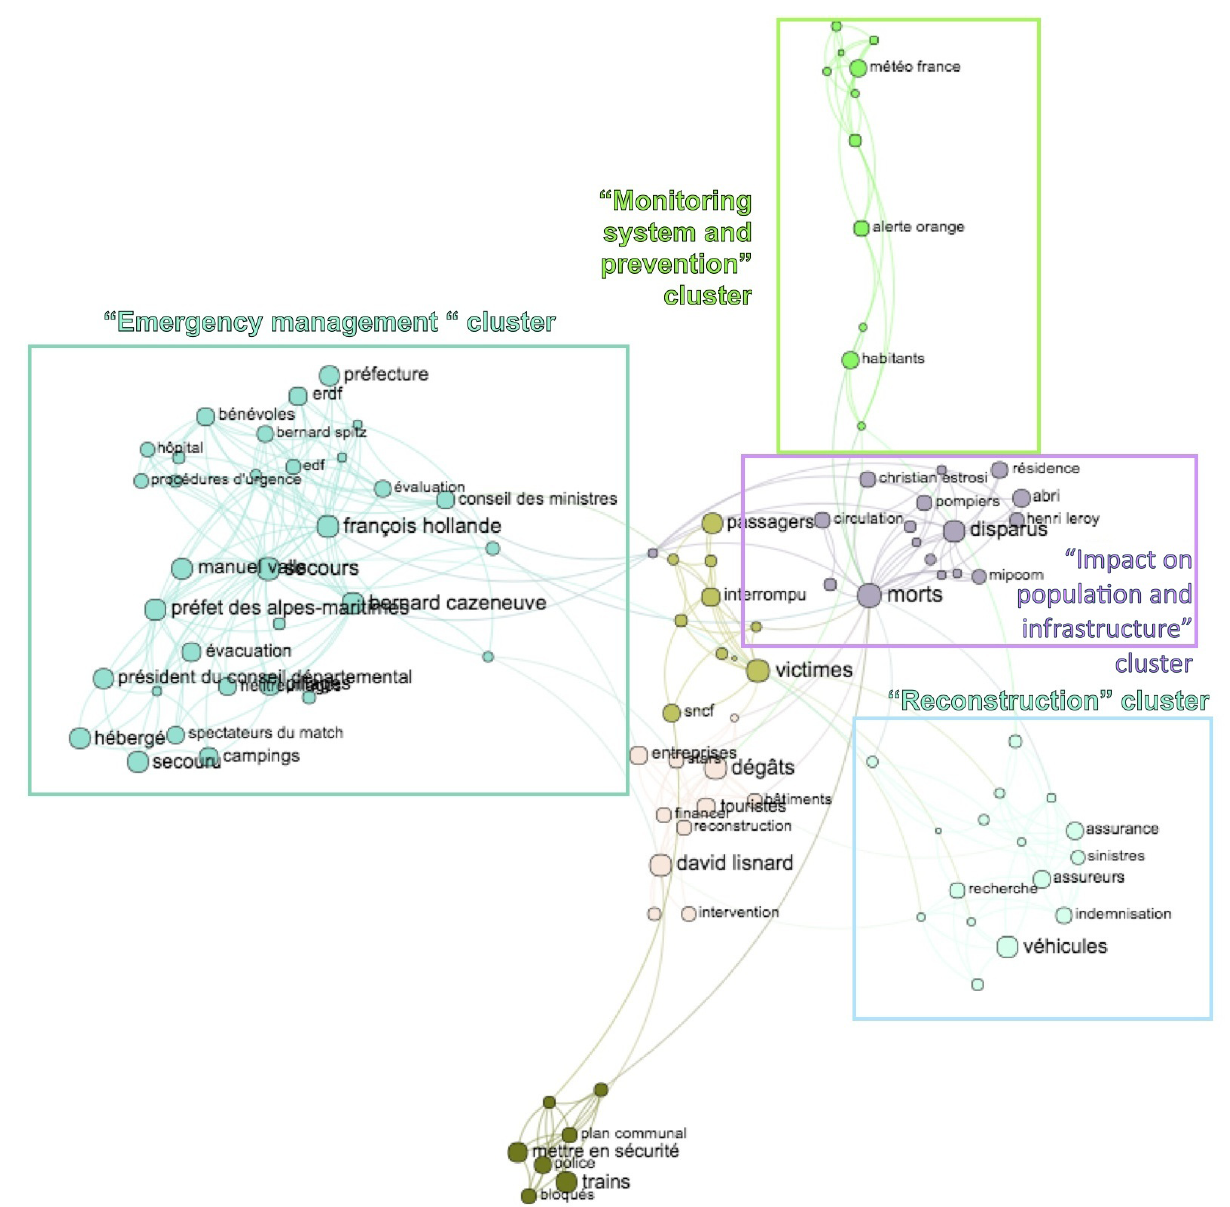
Figure 3. Graph representation computed with the press articles on the 2015 flood in the Alpes-Maritimes region: co-occurrence graph computed on the basis of the measure of conditional proximity between pairs of key terms in the corpus of